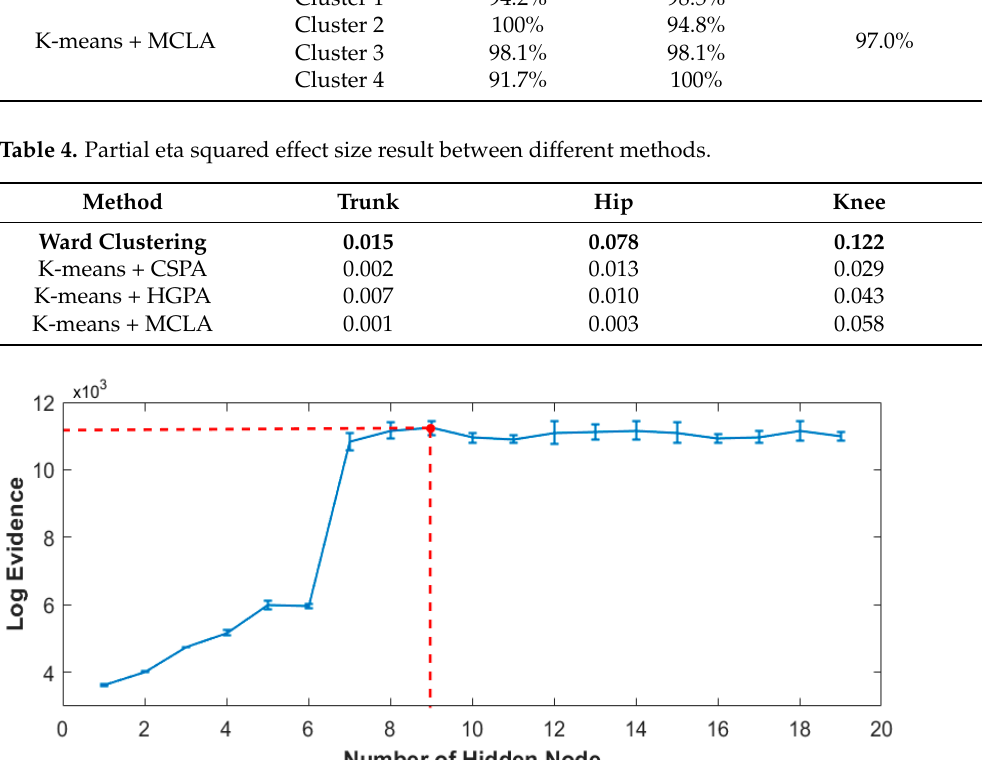
Table 3. Classification results (recall, precision and accuracy) of Bayesian neural network between